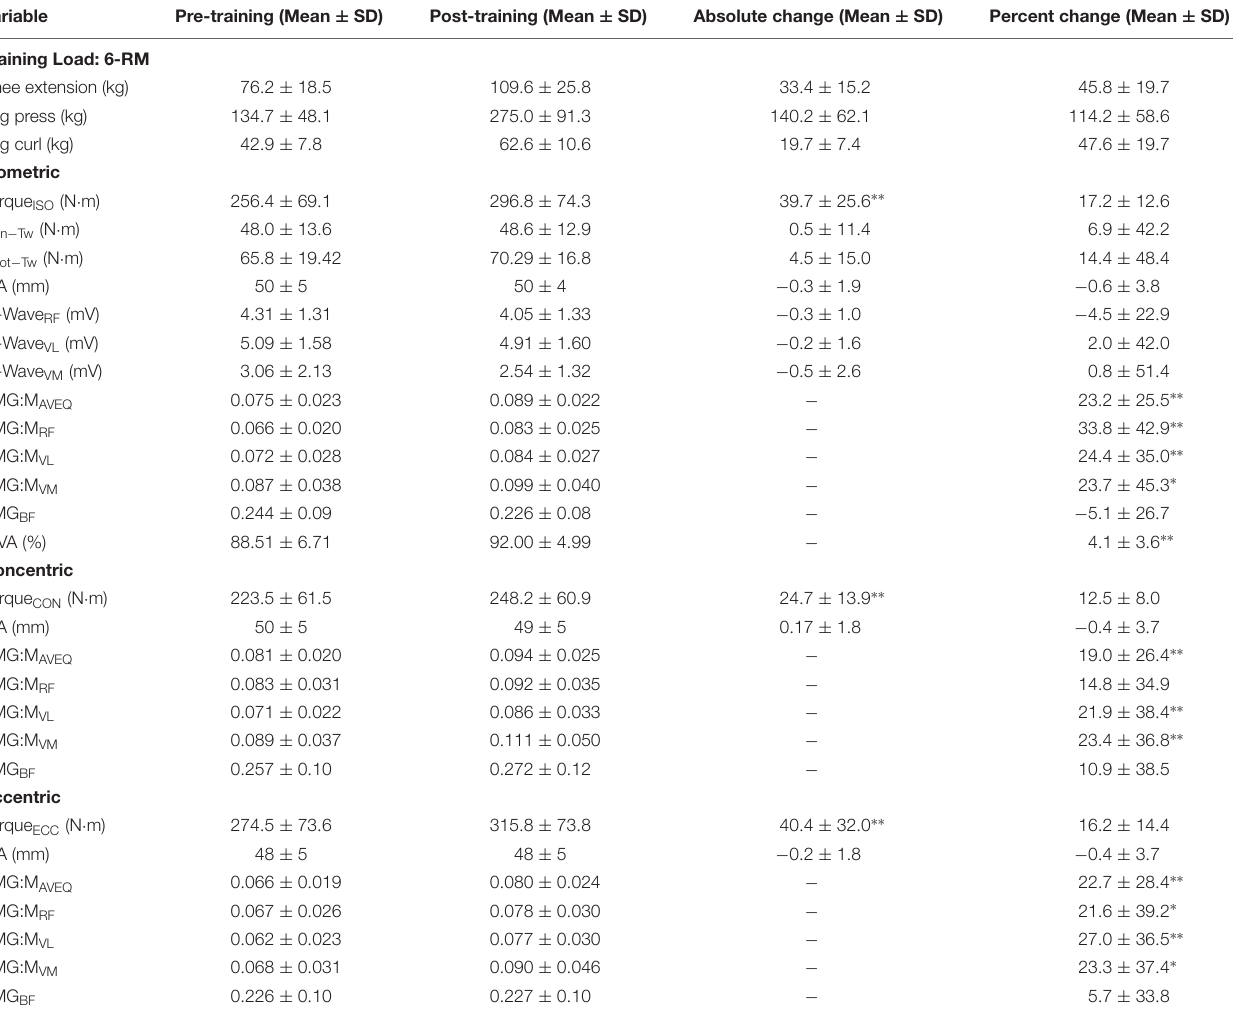
TABLE 1 | Training loads, and torque, moment arm, and muscle activity and activation variables obtained before and after training during maximal isometric, and isokinetic concentric and eccentric contractions.